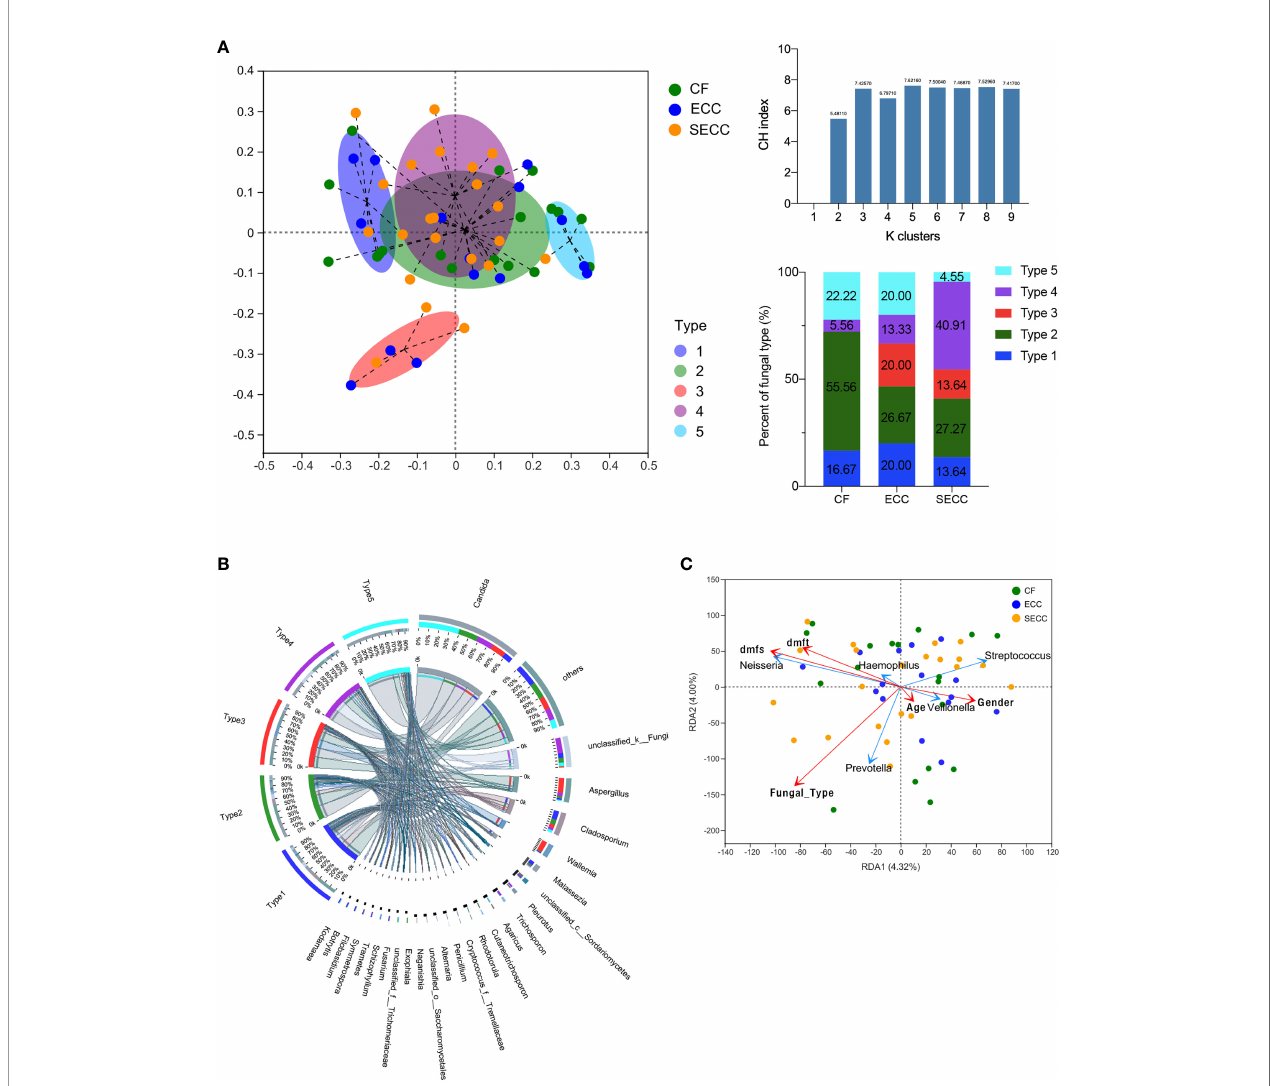
FIGURE 3 | Association between salivary fungi and oral health condition and salivary bacterial pro fi le. (A) The distribution of samples based on the highest CH indices using the PAM algorithm (Bray – Curtis distance) and the proportions of fi ve fungal types in three groups. (B) Pro fi les of each fungal type at the genus level. (C) Correlation between salivary bacterial community structure and host factors by using RDA. CF, caries free; CH indices, Calinski – Harabasz indices; ECC, early childhood caries; PAM, partitioning around medoids; RDA, redundancy analysis; SECC, severe early childhood